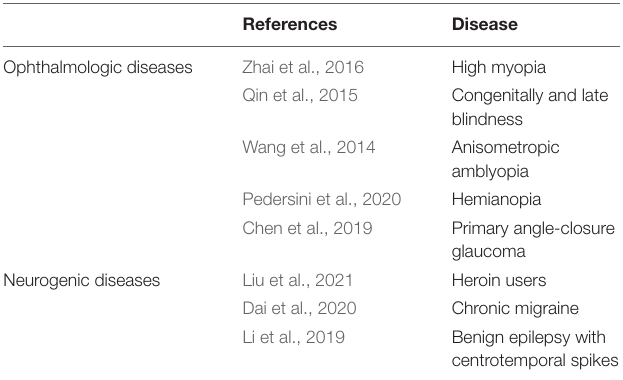
TABLE 4 | Functional connectivity density method applied in ophthalmologic and neurogenic